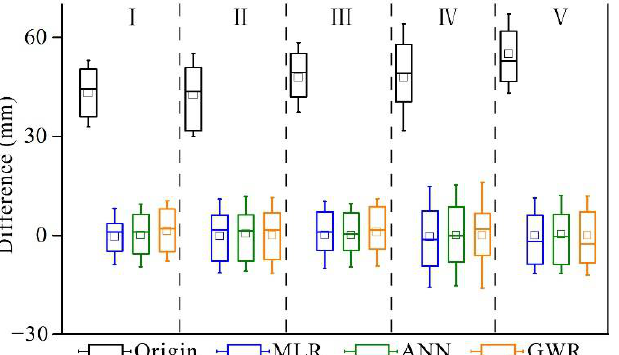
Figure 6. The precipitation difference of original IMERG LR product (Origin) and three correction products (multiple linear regression (MLR), artificial neural network (ANN), and geographically weighted regression (GWR)) compared with observation data.